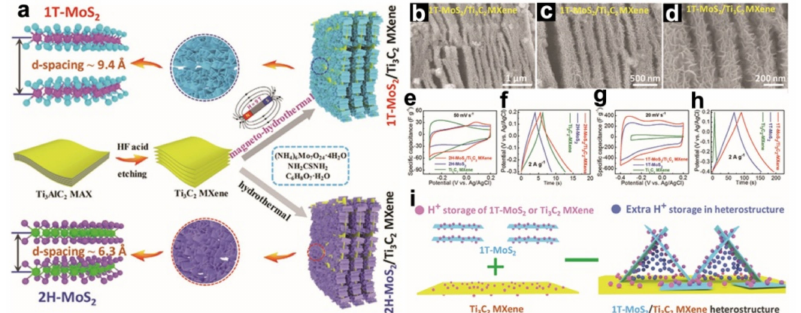
Figure 4. ( a ) Schematic illustrating the preparation process for the two types of the MoS 2 /Ti 3 C 2 MXene 3D heterostructures. ( b – d ) SEM images of the prepared 1T-MoS 2 /Ti 3 C 2 MXene sample. ( c ) Electrochemical performance of the prepared heterogeneous electrodes. ( e – h ) Electrochemical performance of the prepared samples. ( i ) Schematic diagram of the storage mechanism for the heterostructure